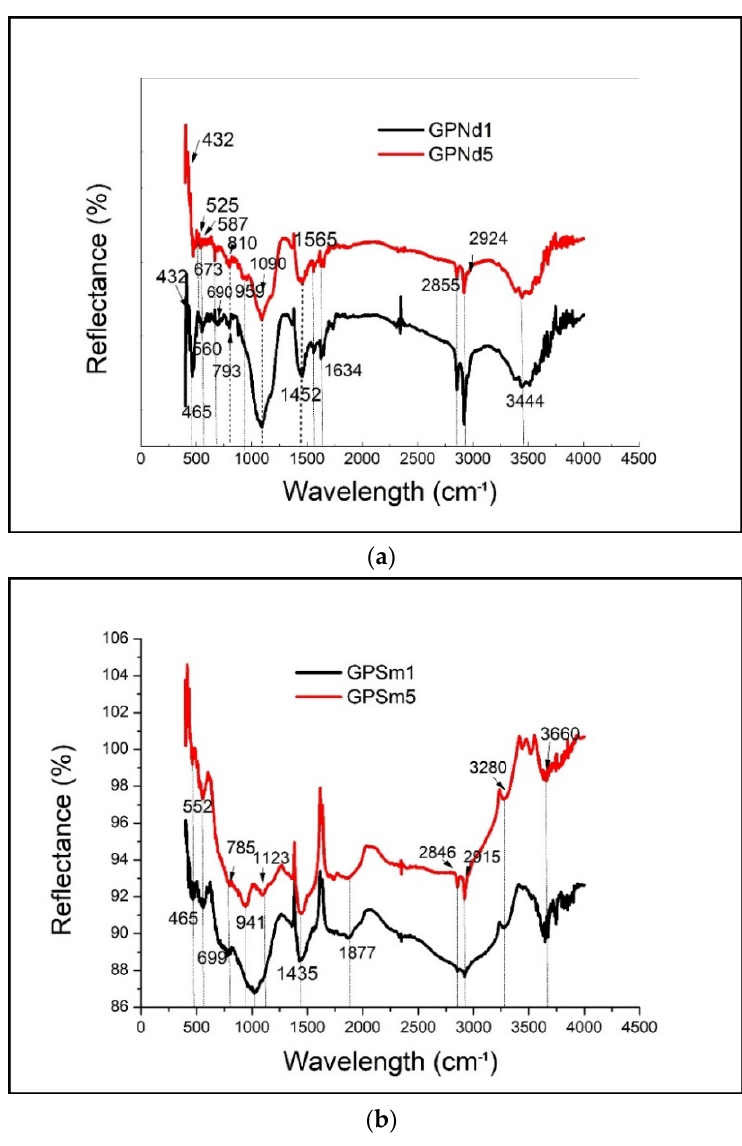
Figure 2. DRIFT spectra of: ( a ) GPNd and ( b )